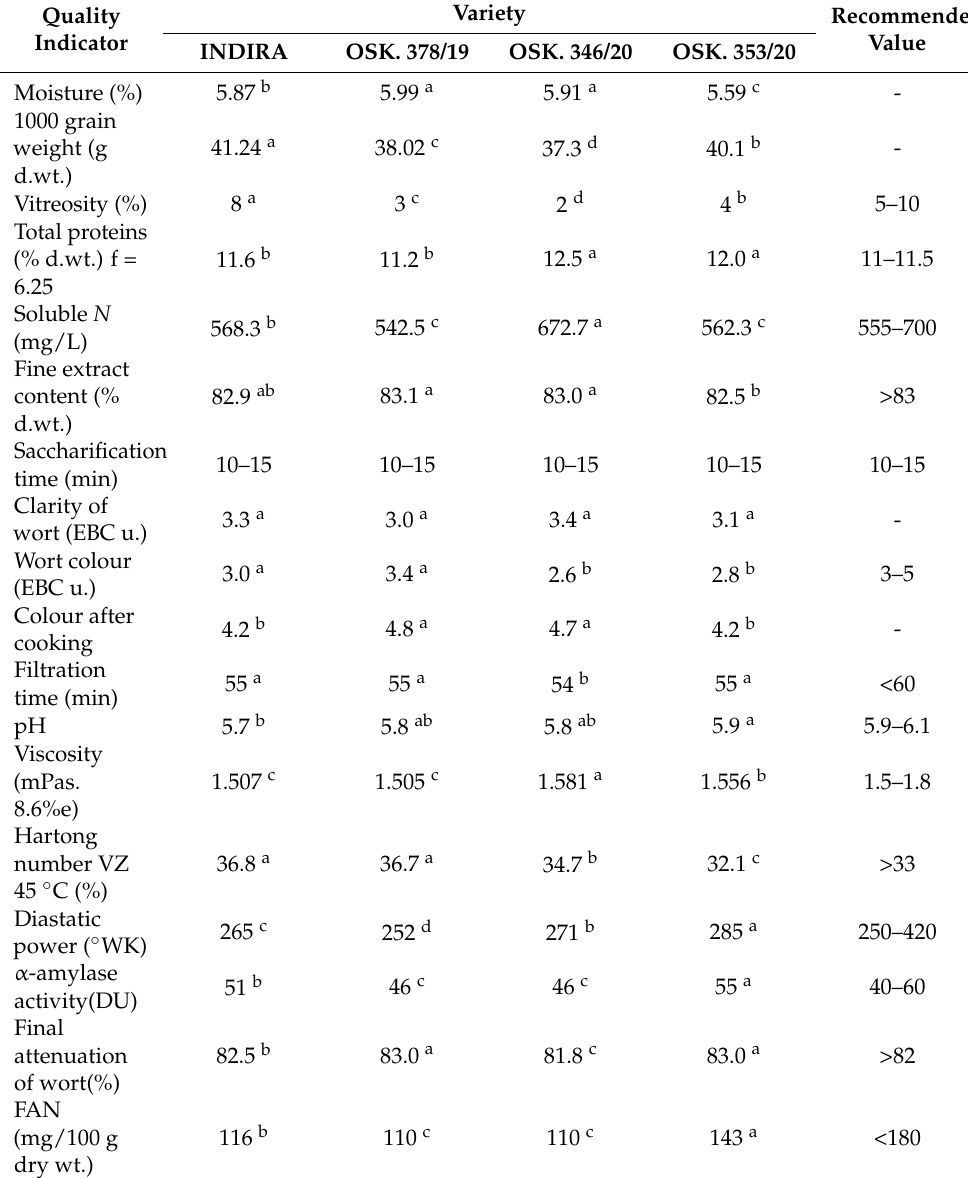
Table 4. Results of malt